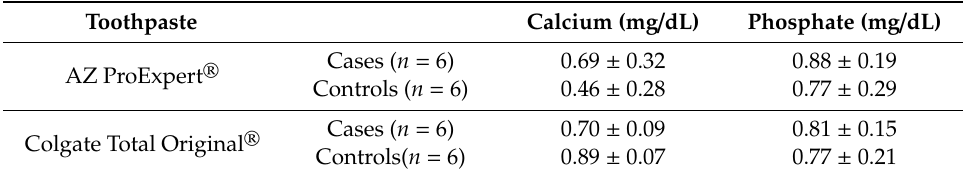
Table 1. Enamel samples in citric acid solution.